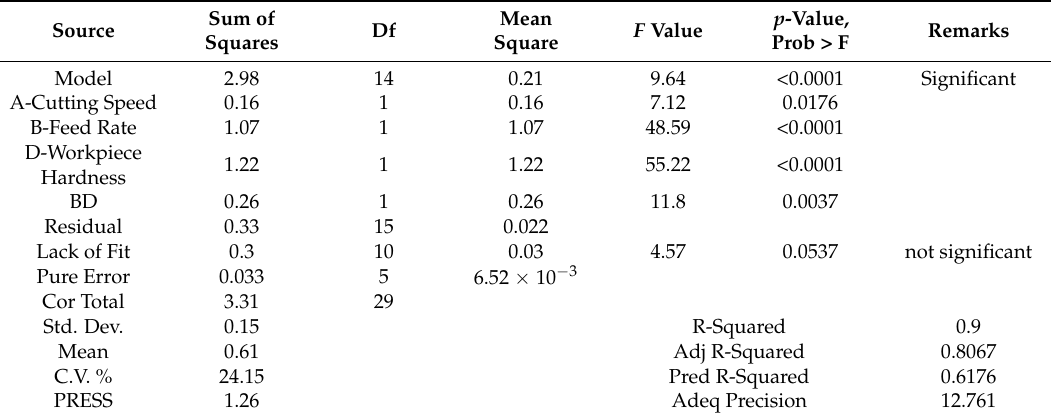
Table 6. ANOVA model of Surface Roughness for CBN-II